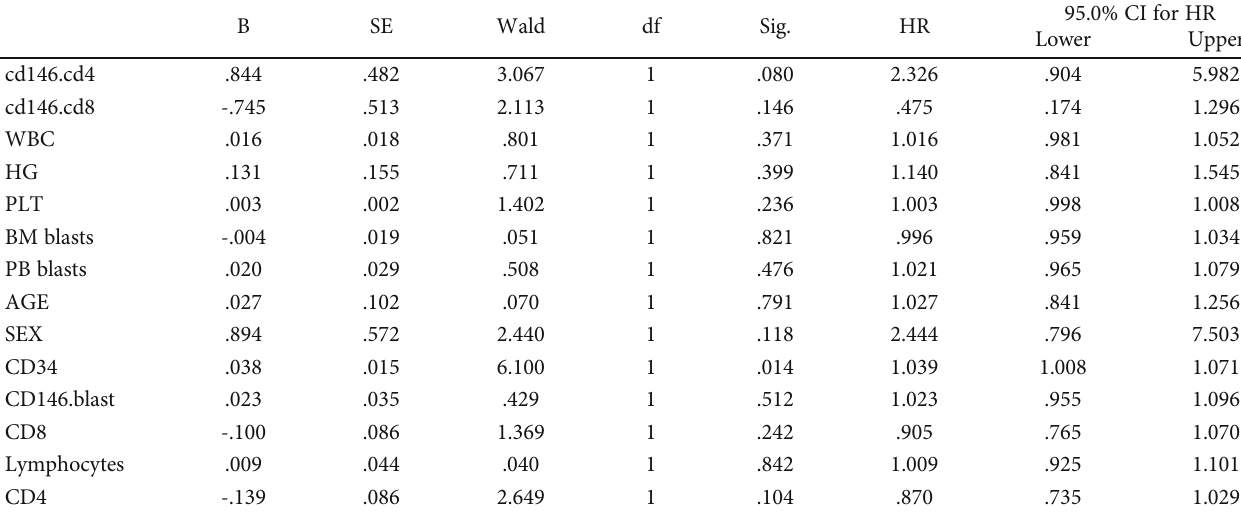
Table 6: Cox regression analysis of di ff erent prognostic factors of